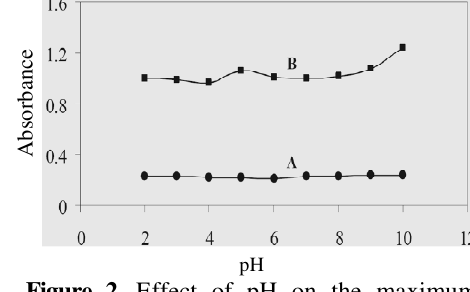
Figure 2. Effect of pH on the maximum absorption spectra of guaifenesin and theophylline. Conditions: Britton Robinson buffer (0.01 mol L -1 ), guaifenesin concentration 10 µmol L -1 , theophylline concentration 10 µmol L